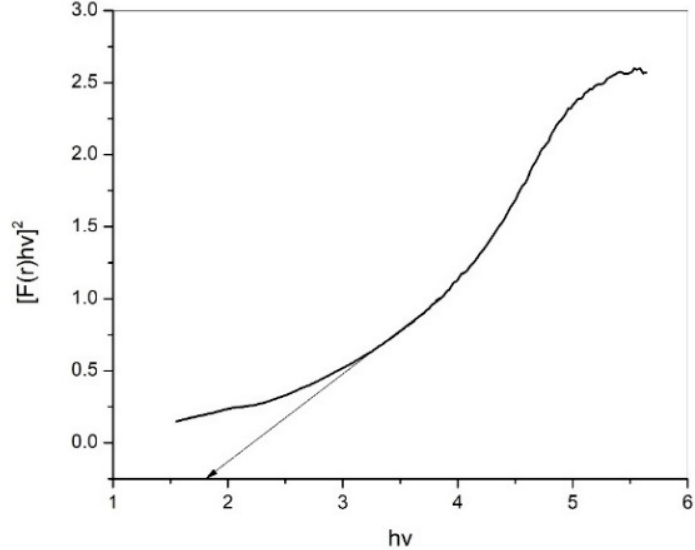
Figure 7. Energy bandgap of the CuFe 2 O 4 -70%/rGO/HNT catalyst.